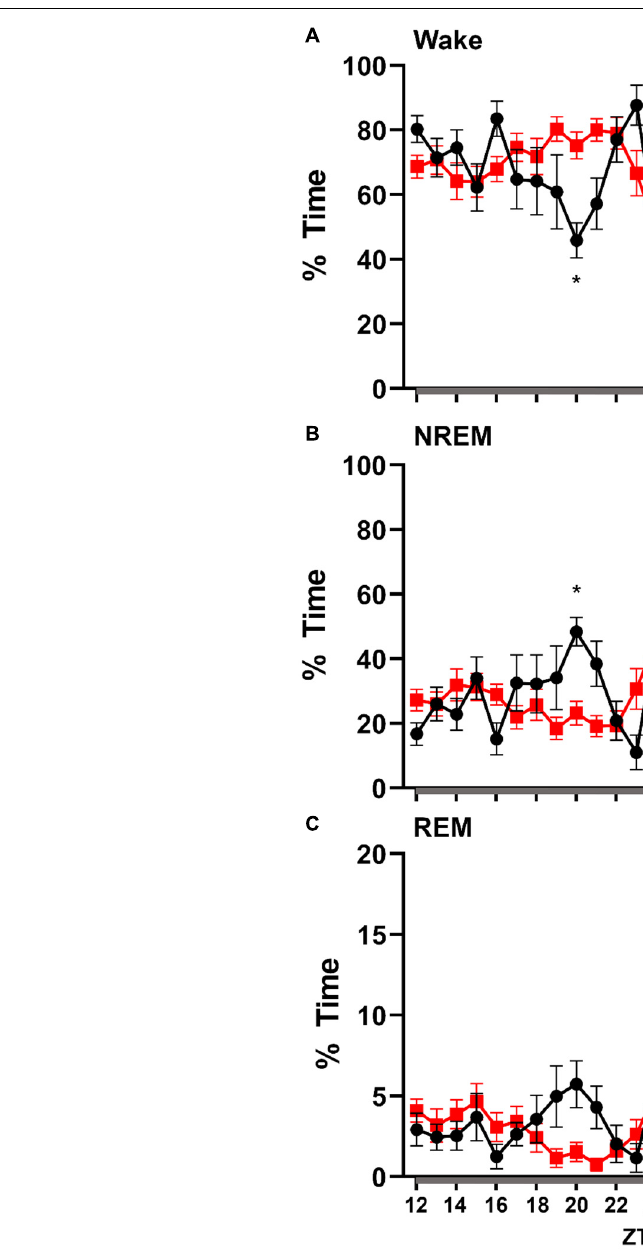
FIGURE 8 | Sleep/wake behavior in WT and Ud6-m-/p+ mice in LD without access to running wheels. Amount of time in Wake (A) , NREM sleep (B) , and REM sleep (C) are similar in WT (black) and Ud6-m-/p+ mice (red) except that Ud6-m-/p+ mice have a blunted “siesta” episode late in the active (dark) interval. Darkness is indicated by the gray horizontal bar from ZT12-24. Data are plotted as mean ± SEM. Asterisk (*) indicates a significant difference between Ud6-m-/p+ vs. WT mice at the p < 0.05